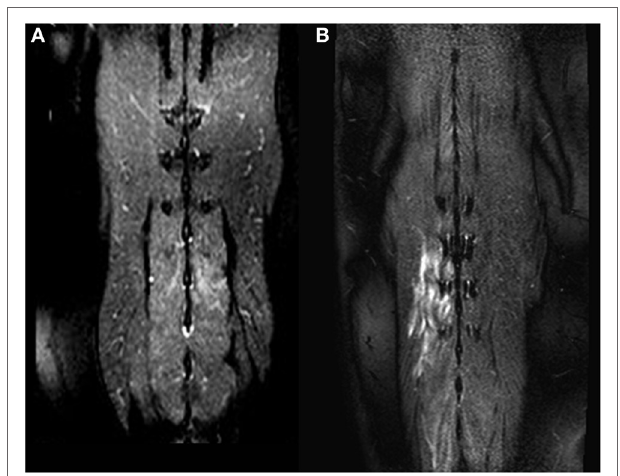
FigUre 1 | Dorsal T2-weighted fat-suppressed images of two different dogs (a,B) . In (a) , only a mild signal alteration is visible in the Mm. multifidi of a French Bulldog with acute intervertebral disk herniation at the level L2/L3. More extensive signal alterations are visible in the Mm. multifidi of a Basset hound (B) with intervertebral disk extrusion at the level T12/T13. Both dogs had a neurologic grade of